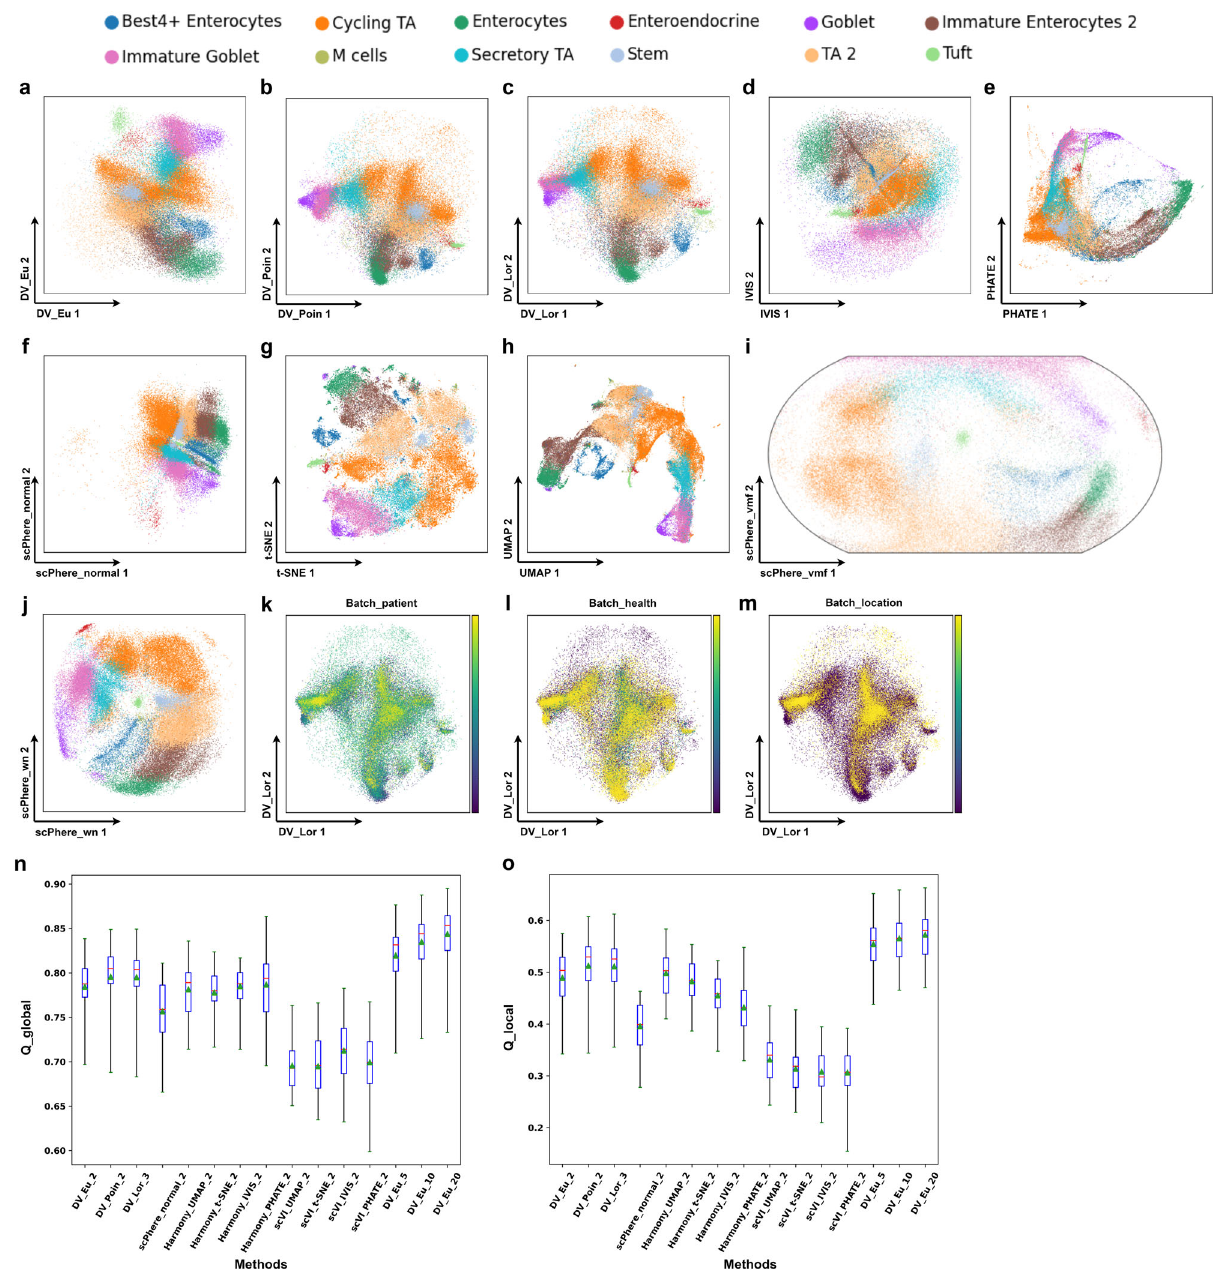
Fig. 5 DV addresses complex technical and biological batch for visualization and analysis in colon biopsies (SCP259) from healthy individuals and UC epithelial patients. DV_Eu ( a ), DV_Poin ( b ), DV_Lor ( c ), scPhere_normal ( f ), scPhere_wn ( j ) and scPhere_vmf ( i ) embeddings accounting for the patient, location and disease status. 2-dimensional IVIS ( d ), PHATE ( e ), t-SNE ( g ) and UMAP ( h ) embeddings (batch-corrected by Harmony accounting for the patient status). DV_Lor embeddings colored by batch_patient ( k ), batch_health ( l ) and batch_location ( m ) label. Successful batch correction